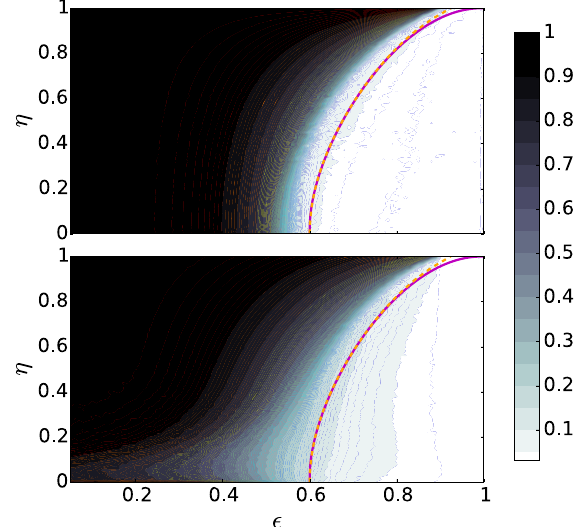
FIG. 3. The overlap for (top) belief propagation and (bottom) our spectral algorithm. The detectability transition in Eq. (10) for T ¼ ∞ is shown as a solid line. The dashed curve shows the detectability transition for T ¼ 40 ; the magenta curve shows the transition for T ¼ ∞ . Each point shows the average over 100 dynamic networks generated by our model with n ¼ 512 , T ¼ 40 , k ¼ 2 groups, and average degree c ¼ 16 . The overlap here is calculated by averaging the maximum overlap at each time slot over all permutations. This maximization step implies that the expected overlap in the undetectable region is O ð n − 1 = 2 Þ , and this produces a small deviation away from overlap ¼ 0 in our numerical experiments.